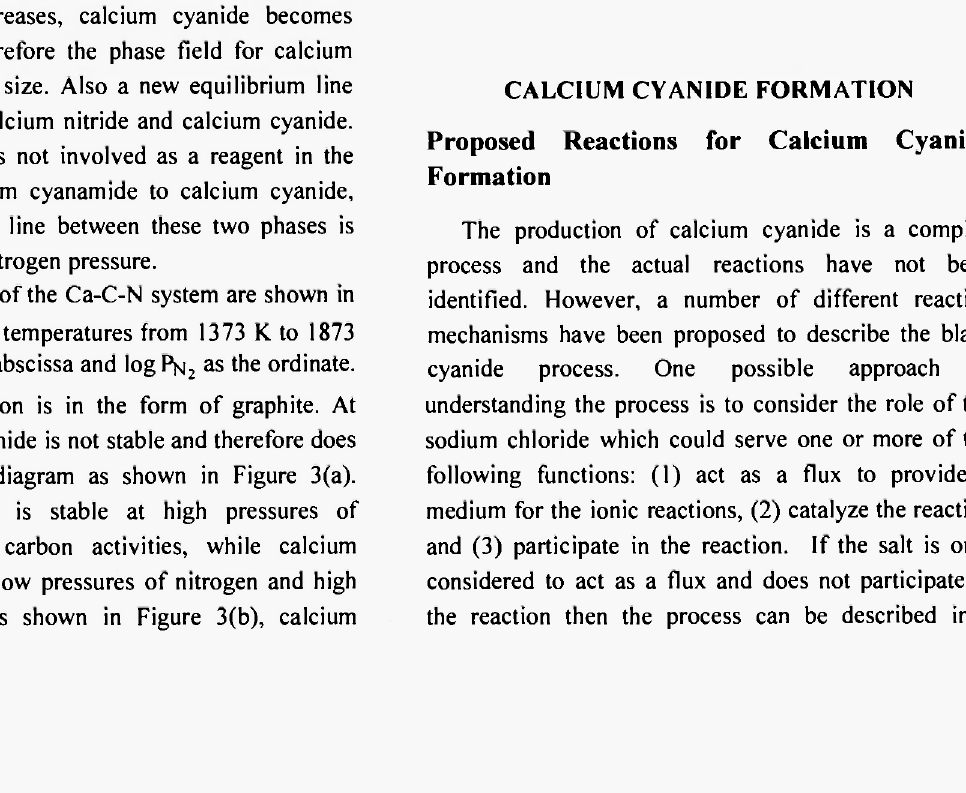
Fig. 2: Three dimensional plot of the predominance area diagram for the calcium-carbon-nitrogen